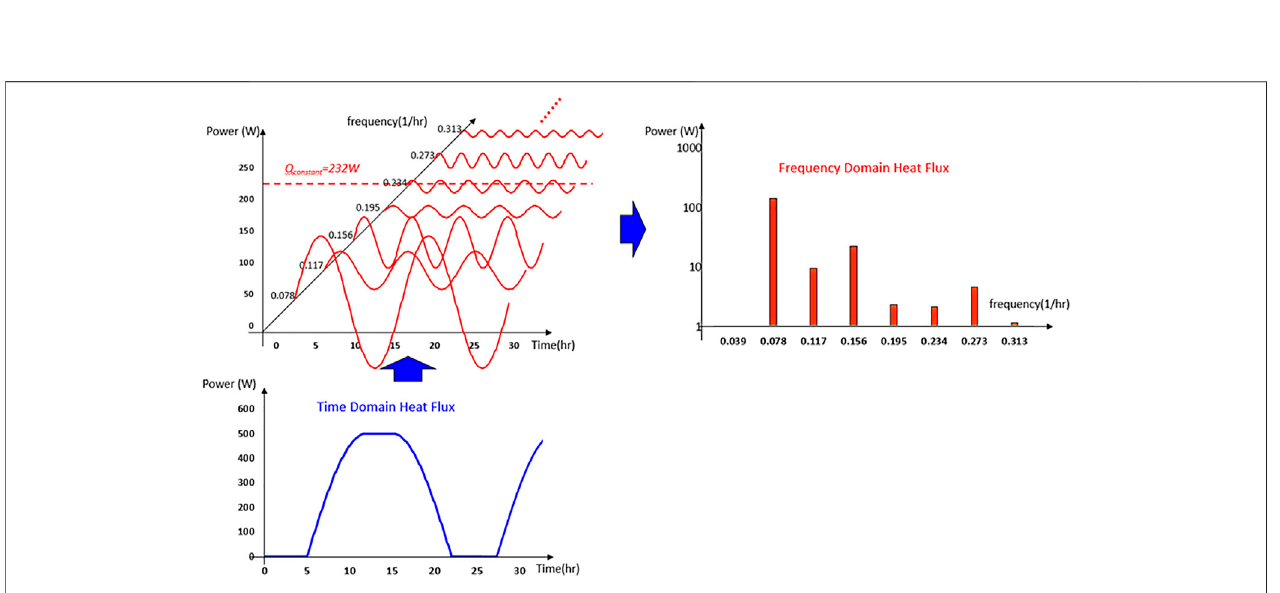
FIGURE 3 | Similarities between buildings and spacecraft in the exposure to periodic external heat fl uxes.